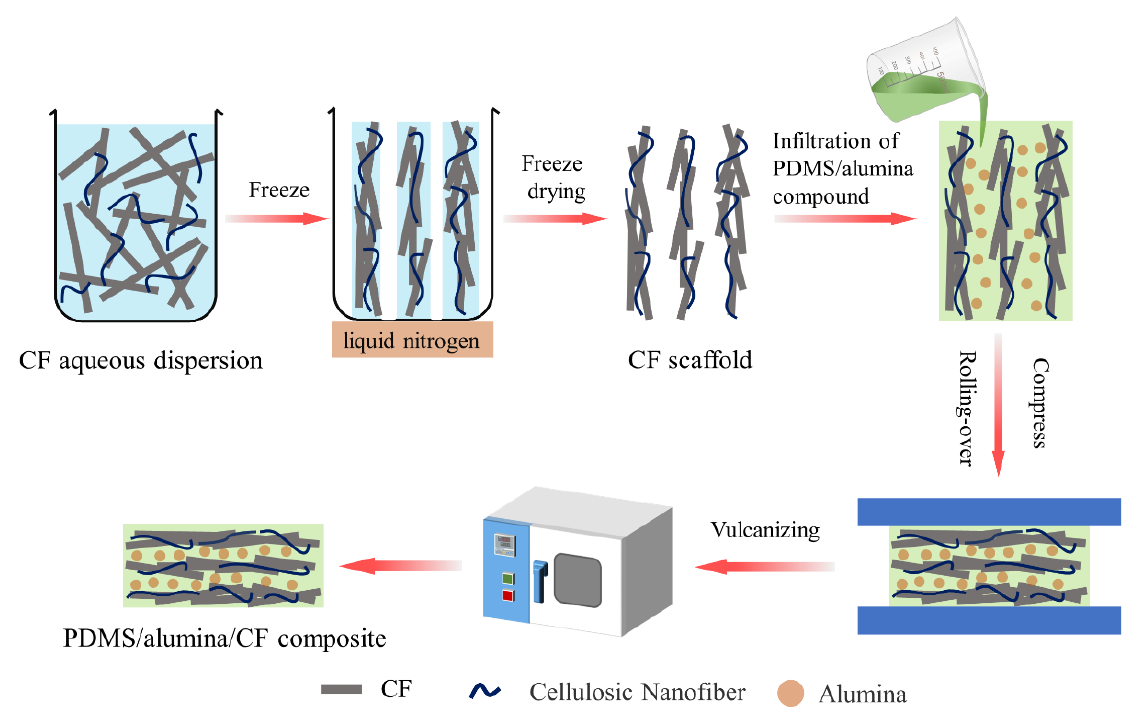
Figure 2. Schematic diagram of the preparation of the CF scaffolds and PDMS/alumina/CF compo- sites.